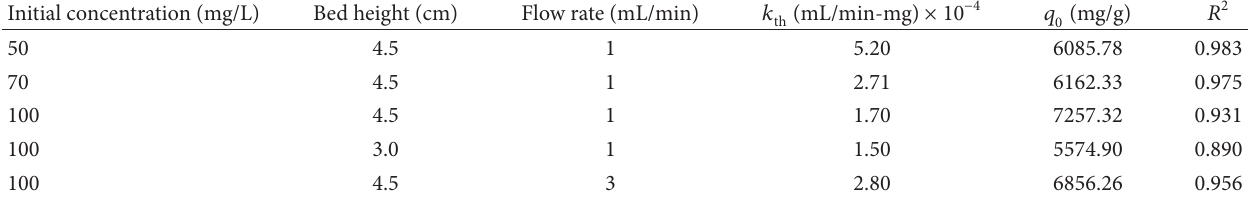
T 3: omas model parameters for manganese (II) at different conditions using linear regression analysis. Initial concentration (mg/L)